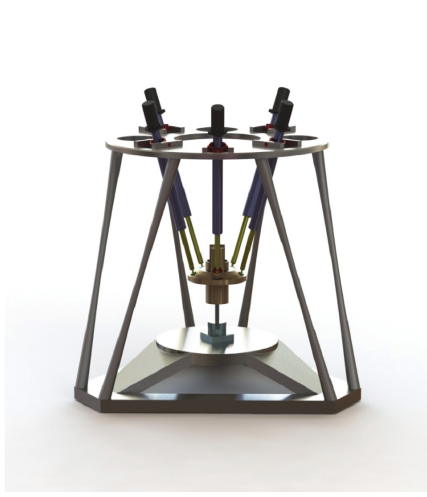
Figure 1: 4-UPS-UPU parallel